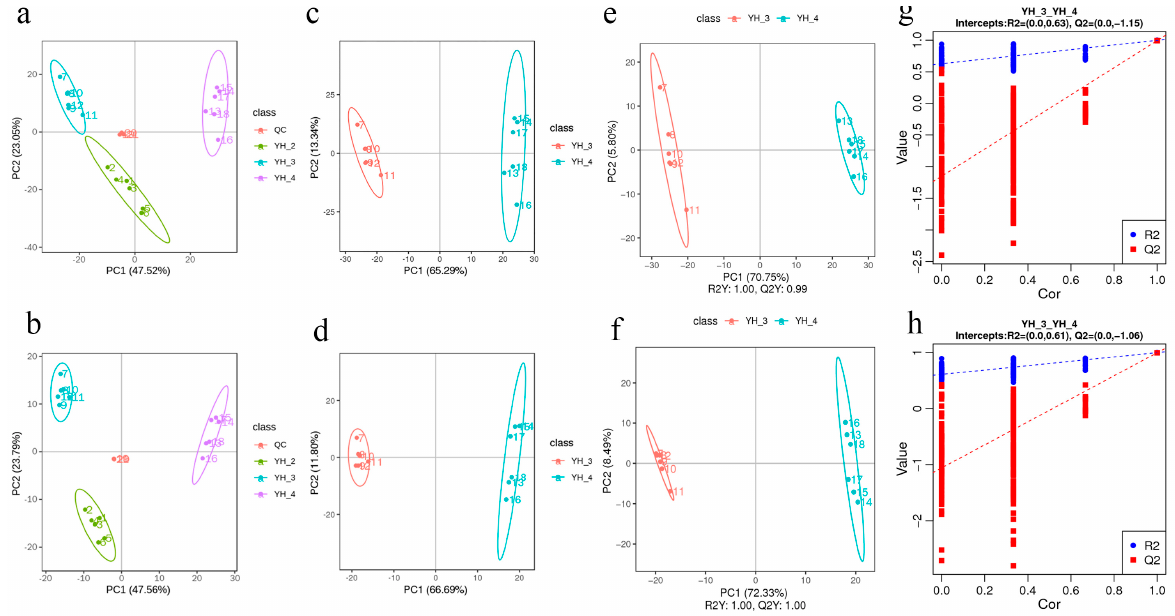
Figure 2. PCA in YH_2 vs. YH_3 vs. YH_4. ( a ) PCA of the variance-stabilized estimated raw counts of DAMs in positive polarity mode in YH_2 vs. YH_3 vs. YH_4. ( b ) PCA of the variance-stabilized estimated raw counts of DAMs in negative polarity mode in YH_2 vs. YH_3 vs. YH_4. ( c ) PCA of the variance-stabilized estimated raw counts of DAMs in positive polarity mode in YH_3 vs. YH_4. ( d ) PCA of the variance-stabilized estimated raw counts of DAMs in negative polarity mode in YH_3 vs. YH_4. ( e ) PLS-DA of DAMs in positive polarity mode. ( f ) PLS-DA of DAMs in negative polarity mode in YH_3 vs. YH_4. ( g ) Permutation test for positive polarity mode. ( h ) Permutation test for negative polarity mode in YH_3 vs. YH_4.